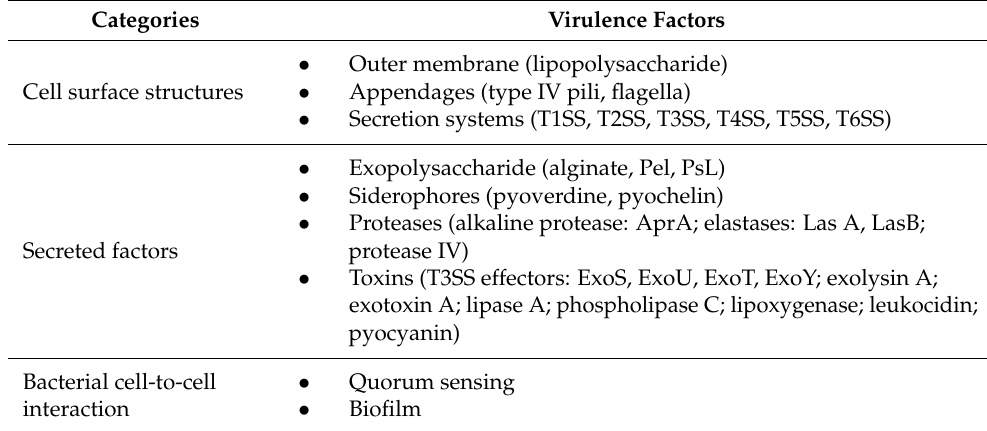
Table 1. P. aeruginosa virulence